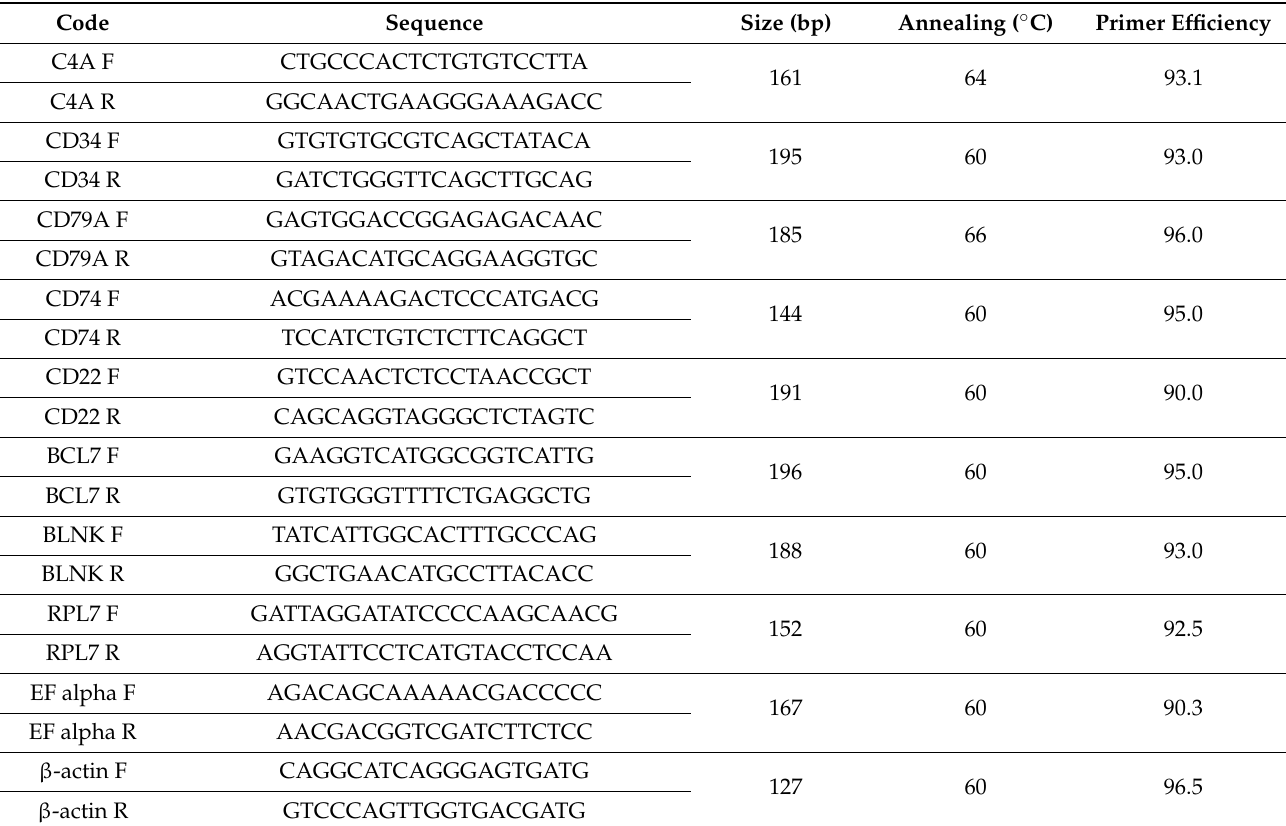
Table 1. List of quantitative qRT-PCR primers used in this study. F: forward; R: reverse; bp: base